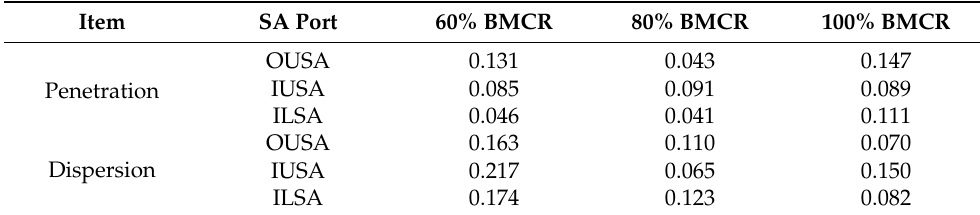
Table 6. Standard deviations of penetration depth and lateral diffusion distance of SA under various boiler loads (unit: